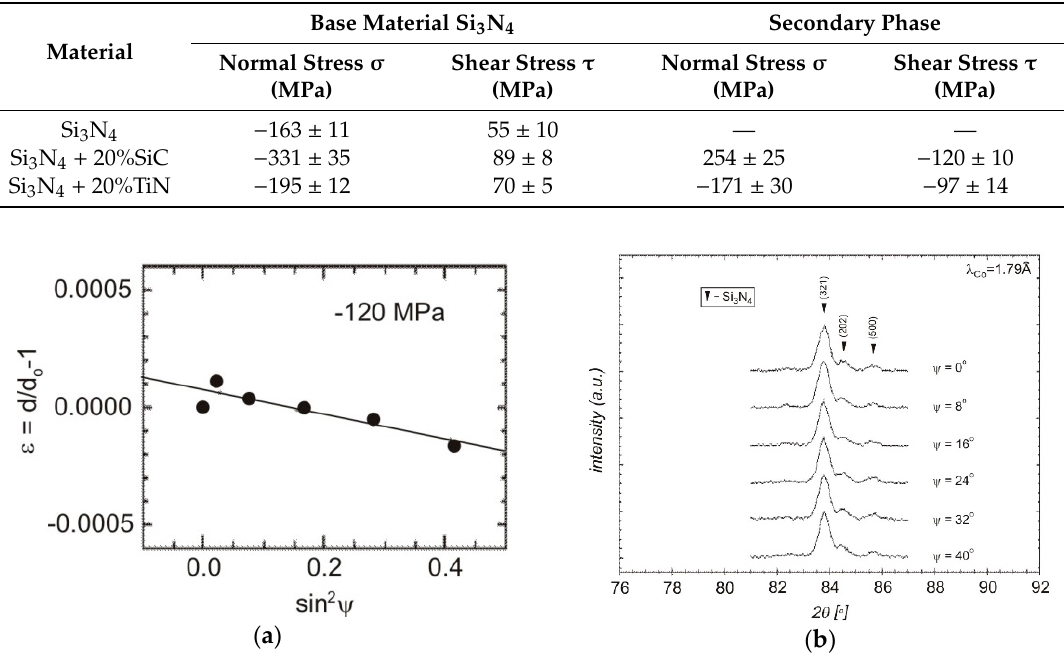
Figure 8. Linear relationship ε ϕψ = f(sin 2 ψ ) + b in the classical sin 2 ψ method ( a ) and view of the registered line {321} for individual inclination angle ψ ( b ). Table 6. Measured surface residual stresses in silicon nitride-based materials and secondary phases.